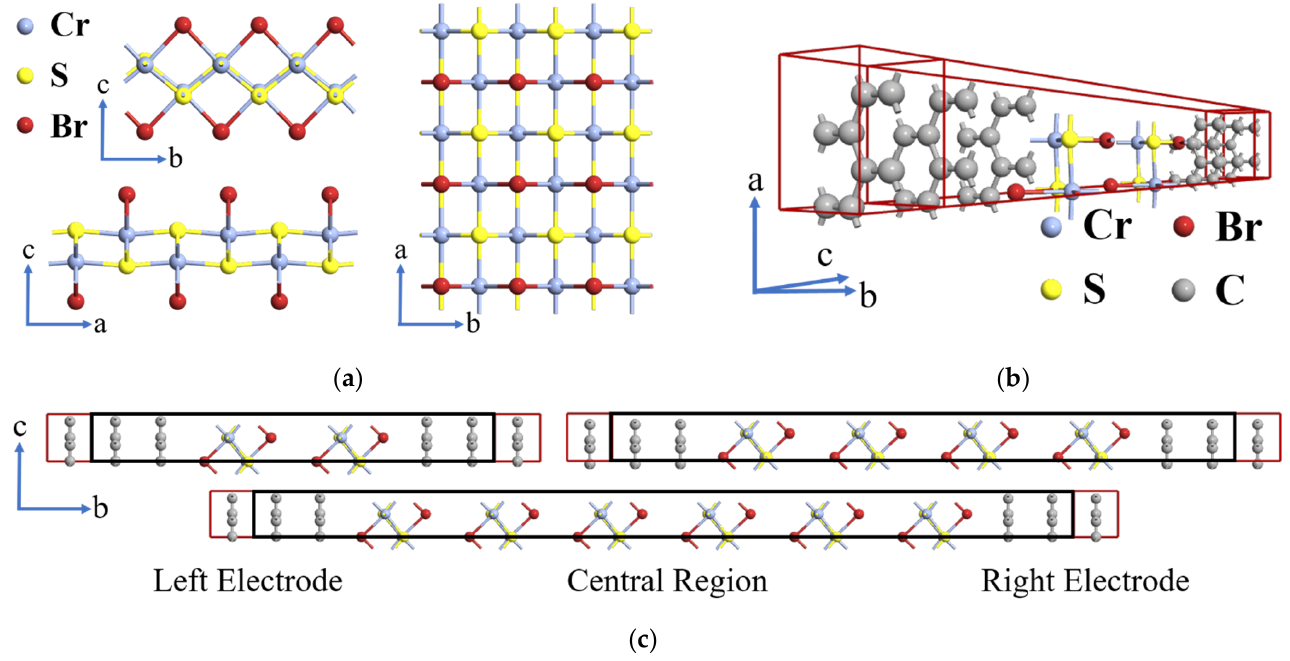
Figure 3. ( a ) Structure of monolayer CrSBr (3 × 3) viewed along the a axis, b axis and c axis. Cr, S and Br atoms are colored in blue, yellow and red, respectively; ( b ) The perspective view diagram of a graphene/bilayer CrSBr/graphene sf-MTJ device. C atoms are colored in gray; ( c ) The device model based on the 2/4/6-layer CrSBr. The red and black squares represent electrodes and central regions, respectively. Table 1. The values of G P (the 2nd column), G AP (the 3rd column) and TMR (the 4th column) of MTJs with different numbers of CrSBr layers through